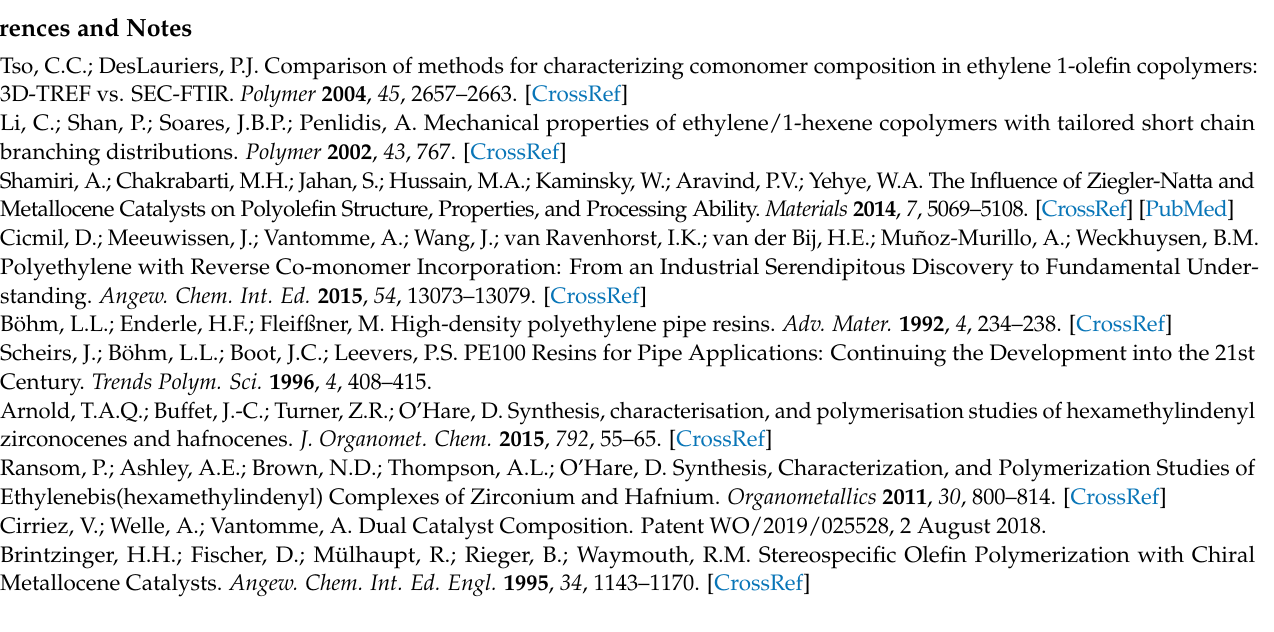
complex 2 ; Figure S3: APPI+-MS spectrum of rac - 2 ; Attempted racemo - and meso -selective metallocene synthesis; Figure S4: 1 H NMR spectrum (CD 2 Cl 2 , 400 MHz, 25 ◦ C) of the crude reaction mixture indicating rac - 3 as the major product; Figure S5: 1 H NMR spectrum (400 MHz, CD 2 Cl 2 , 25 ◦ C) of the crude reaction mixture between 3 and Me 2 SiCl 2 affording complex 2 in ca. 4:1 rac/meso ratio; Figure S6: Aromatic region of the 1 H NMR spectrum (400 MHz, CD 2 Cl 2 , 25 ◦ C) of the crude reaction mixture resulting from the attempted meso -selective synthesis of complex 2 , indicating the presence of both rac - and meso isomers (ca. 1:1 ratio), as well as unreacted ligand 1 ; Figure S7: 13 C{ 1 H} NMR spectrum (100 MHz, TCB/C 6 D 6 , 135 ◦ C) of a PE synthesized with meso - 2 in the absence of 1-hexene (Table 1, entry 1); Figure S8: 13 C{ 1 H} NMR spectrum (100 MHz, TCB/C 6 D 6 , 135 ◦ C) of a PE copolymer synthesized with meso - 2 in the presence 3.0 wt% of 1-hexene (Table 1, entry 13); Figure S9: GPC traces of the PEs made with supp- rac -2 (orange) and supp- meso -2 (blue) (Table 2, entries 1 and 2); Figure S10: GPC traces of the PEs prepared with supp- meso -2 in the presence of difference amounts of 1-hexene (Table 2, entries 3, 5, 7, and 9): all curves are perfectly overlapped; Computational Studies; Cartesian coordinates